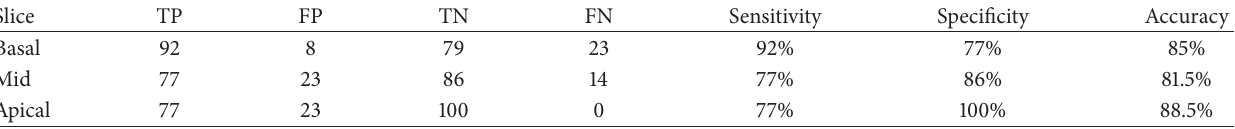
Table 2: Classification results according to one principal component, values represented as percentages.